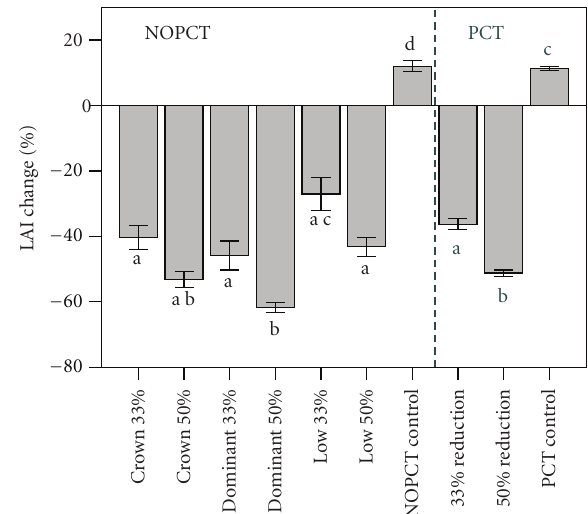
Figure 2: Direction and magnitude of net leaf area index (LAI) changes for the commercial thinning types (crown, dominant, low) and reduction levels (33% and 50%) implemented by the Cooperative Forestry Research Unit Commercial Thinning Research Network. Statistical analysis was conducted independently for PCT (precommercial thinning history) and NOPCT (no history of precommercial thinning) groups. Letters represent significant di ff erences determined using Tukey’s